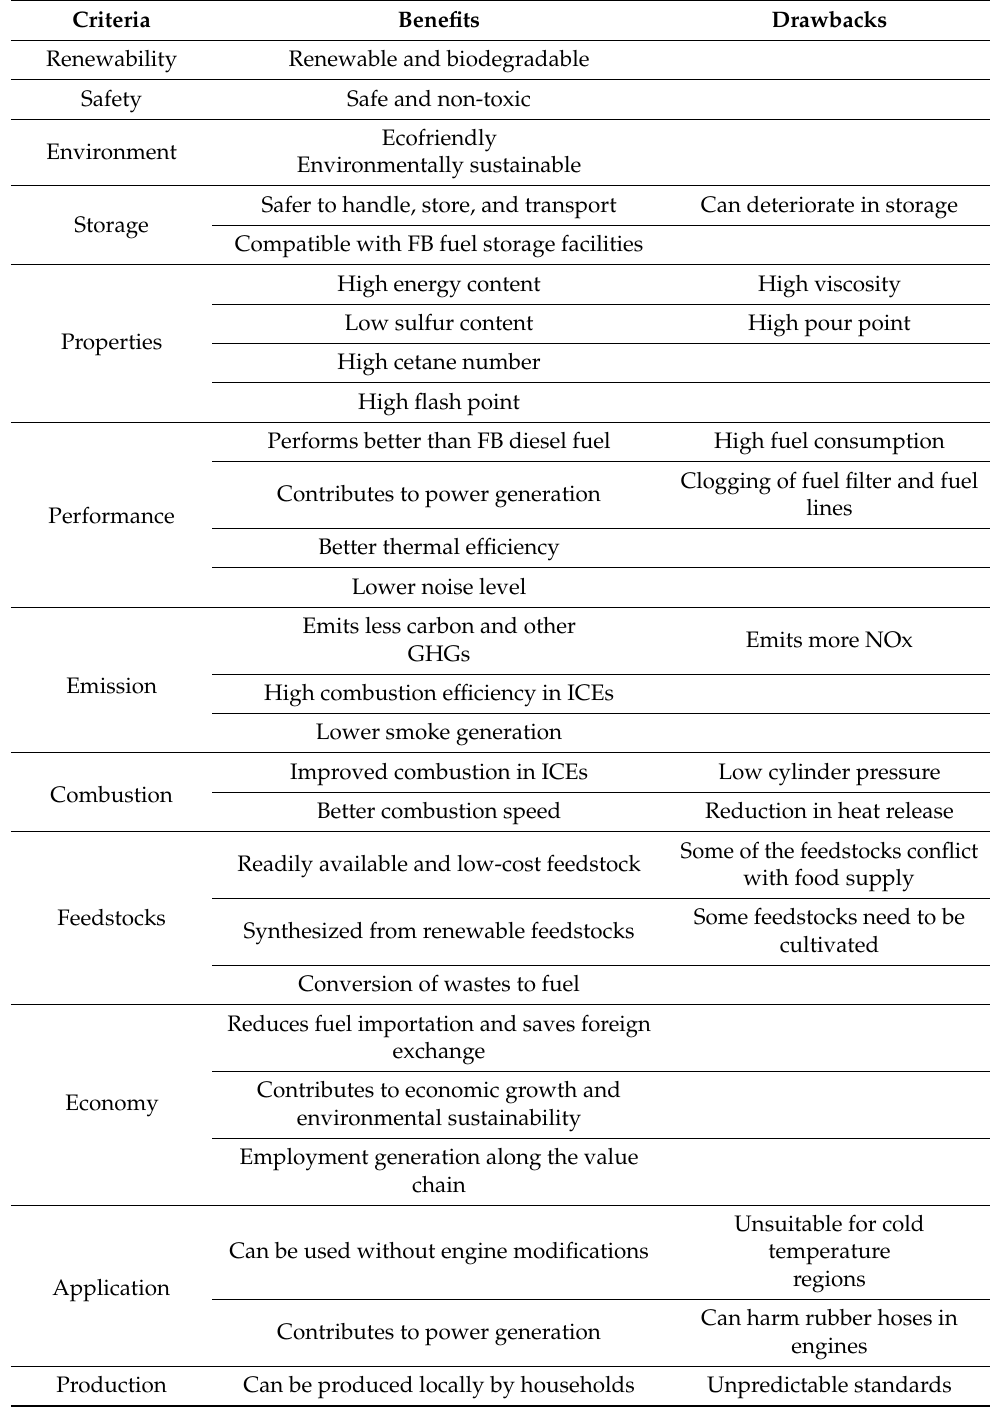
Table 1. Benefits and drawbacks of biodiesel